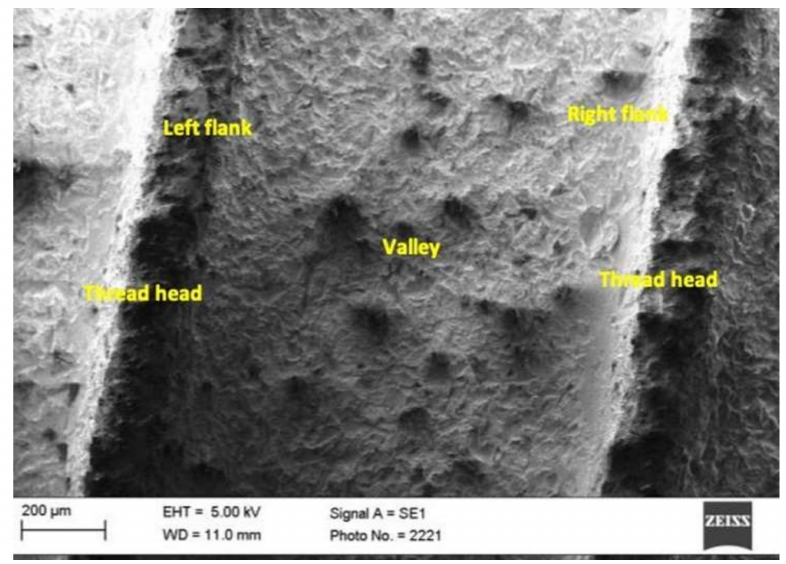
Figure 4. SEM image of an implant, which is divided into different partial surfaces in the thread, such as head, valley, and right and left